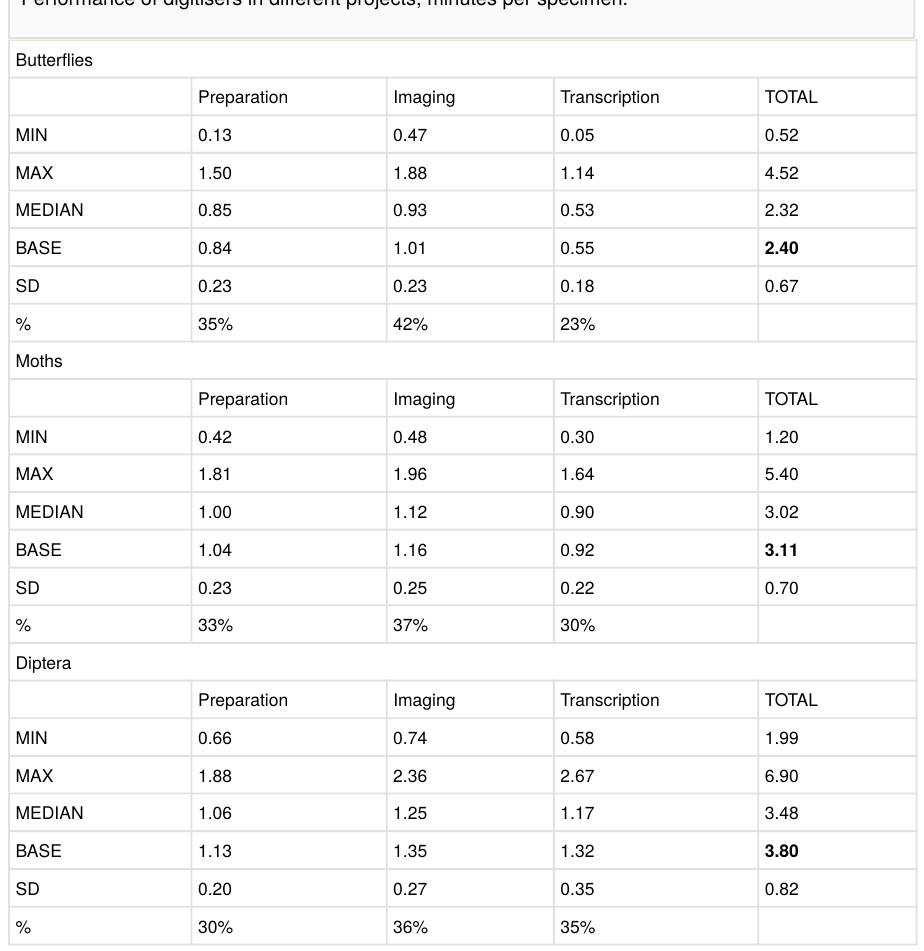
Performance of digitisers in di ff erent projects, minutes per